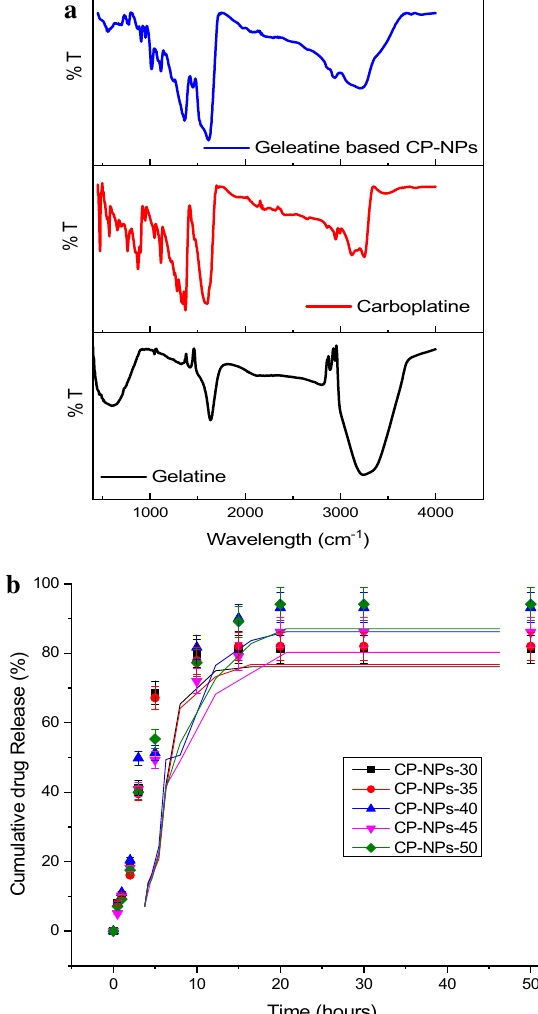
Figure 4. ( A ) FTIR Spectrum of Gelatine, Carboplatine and Gelatine based CP-NPs. ( B ) Drug release rate (%) of CP-NPs-30, CP-NPs-35, CP-NPs-40, CP-NPs-45, CP-NPs-50